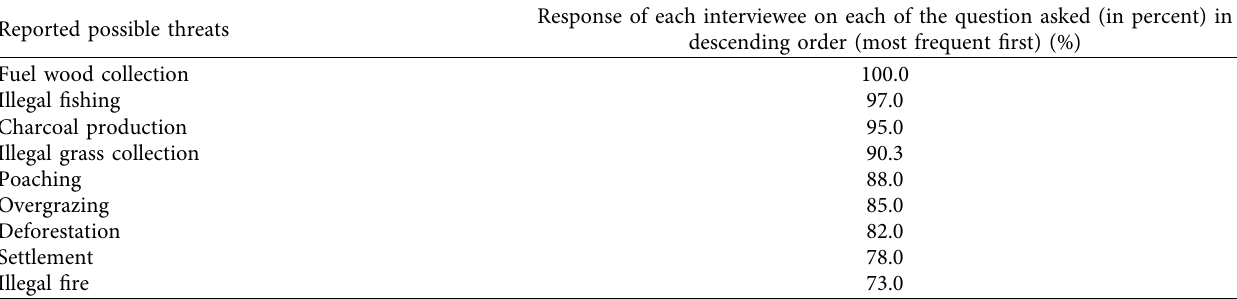
Table 5: Possible threats with their respective mean percent based on each respondent’s response ( n � 21). Reported possible